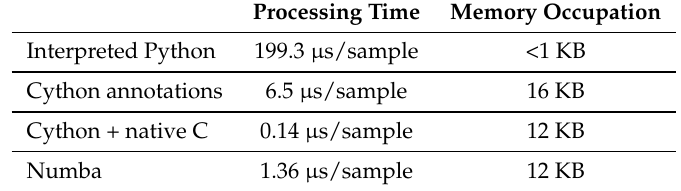
Table 2. Voltage-controlled filter: mean processing time and memory occupation of different implementations; chunk_size = 512; processing time averaged over 1000 chunks. (Real-time limit: 22.6 µ